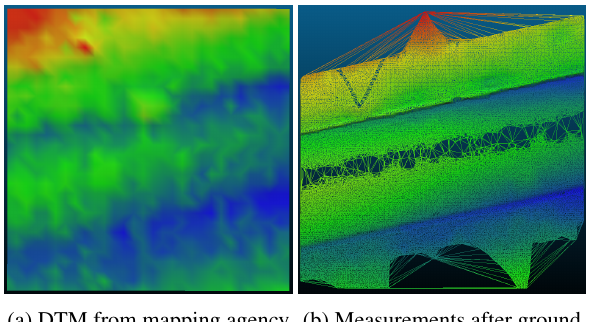
Figure 7. Comparison of point cloud before ground filtering (left) and after ground filtering (right)